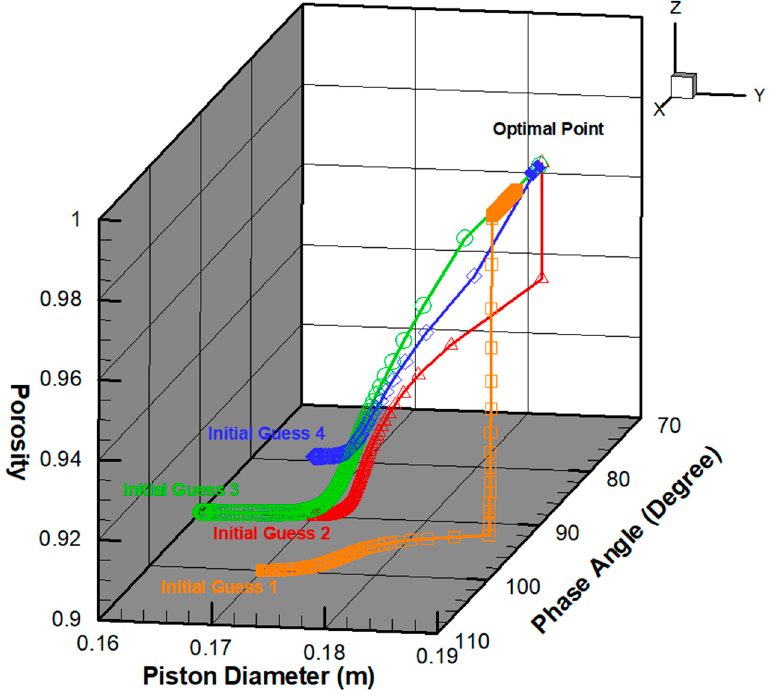
Figure 9. Optimization processes with four different initial guesses.